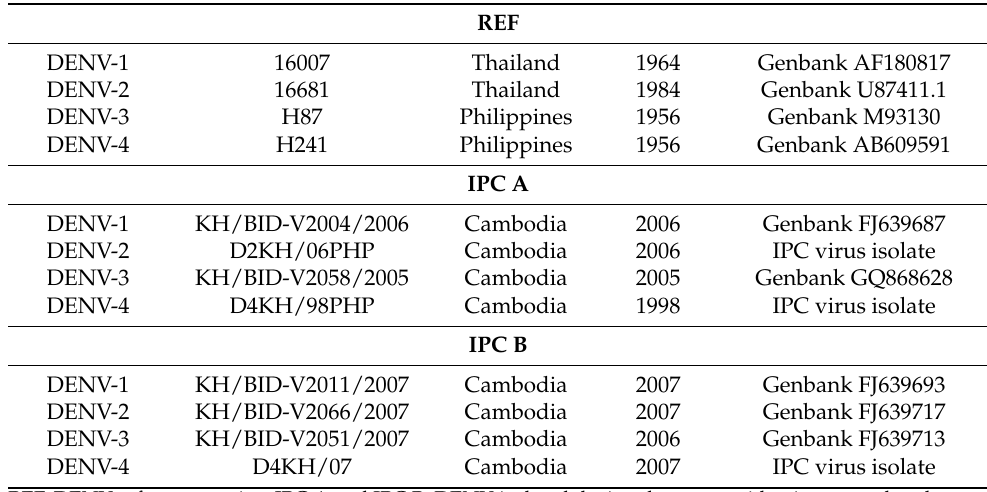
Table 1. The three sets of dengue viruses used for the foci reduction neutralization test (FRNT 90